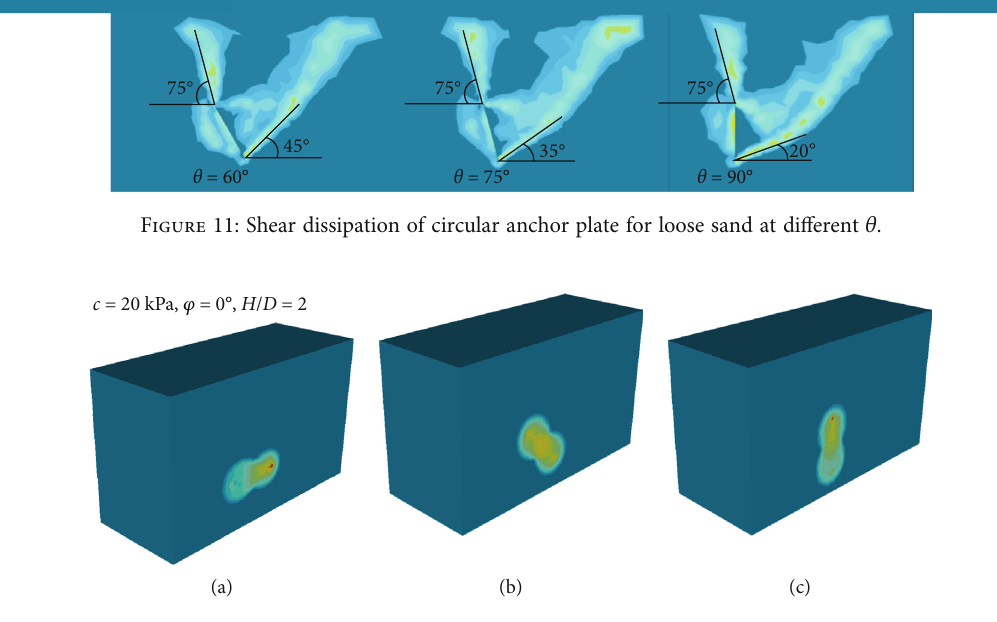
Figure 12: 3D-Failure surface of circular anchor plate at (a) θ = 0 ° , (b) θ = 45 ° , and (c) θ = 90 ° for φ = 0 °